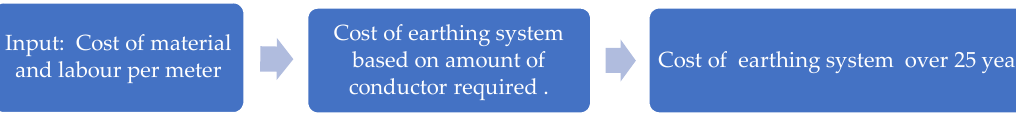
Figure 5. Process to determine the earthing system cost over 25 years.